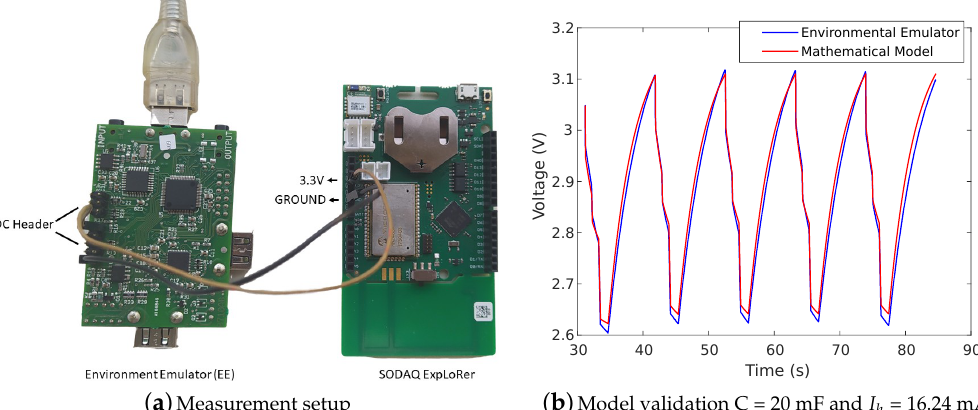
Figure 7. Mathematical model validation using an environment emulator.